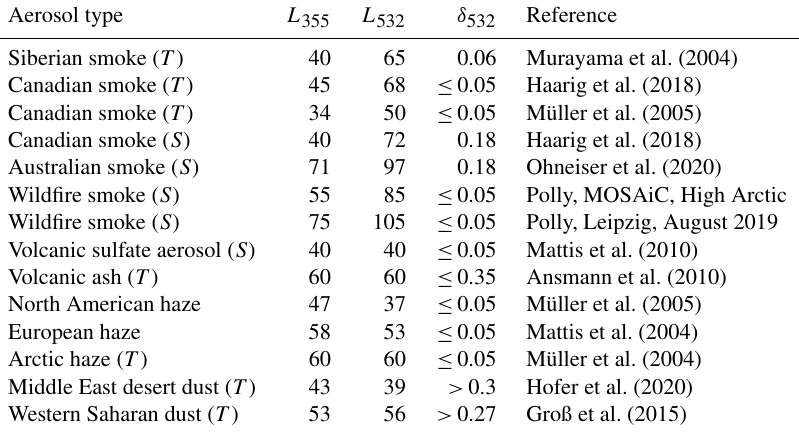
Table 2. Typical lidar ratio pairs ( L 355 , L 532 in steradian (sr), measured at 355 and 532nm) in aged tropospheric ( T ) and stratospheric ( S ) smoke layers. Lidar ratio pairs for further aerosol types are given for comparison. All measurements are performed with multiwavelength polarization Raman lidars. The particle depolarization ratio δ 532 at 532nm is given in addition and is usually < 0.05 for spherical